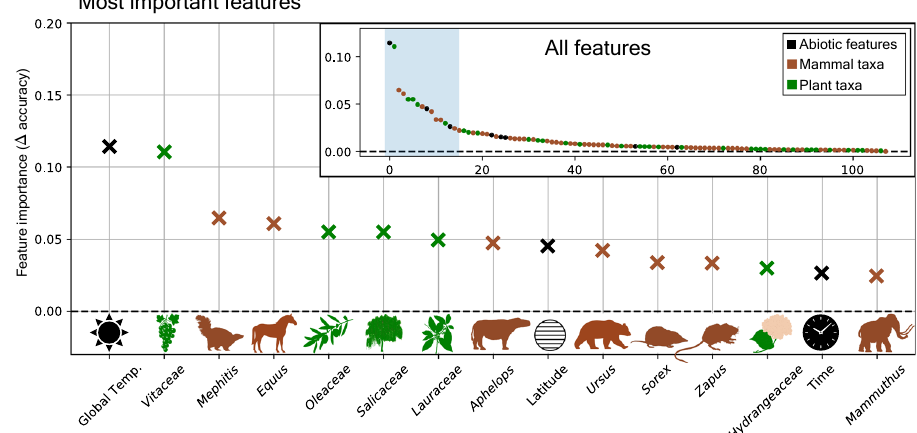
Fig. 5 | Impact of individual features on model prediction accuracy. The dis- playeddelta-accuracyvalues(y-axis)constituteameasureofhowimportantagiven feature is for the trained model to make accurate vegetation predictions. This is determined by measuring the drop in prediction accuracy when the information contentofagivenfeatureisremoved(permutationfeatureimportance).Highdelta accuracy values indicate high feature importance. Points show the mean delta- accuracy of each feature across 100 randomly selected posterior BNN weight samples. The inserted panel ( “ All features ” ) displays an overview of the delta- accuracyestimatesforall108features,whilethemainpaneldisplaysonlythemost